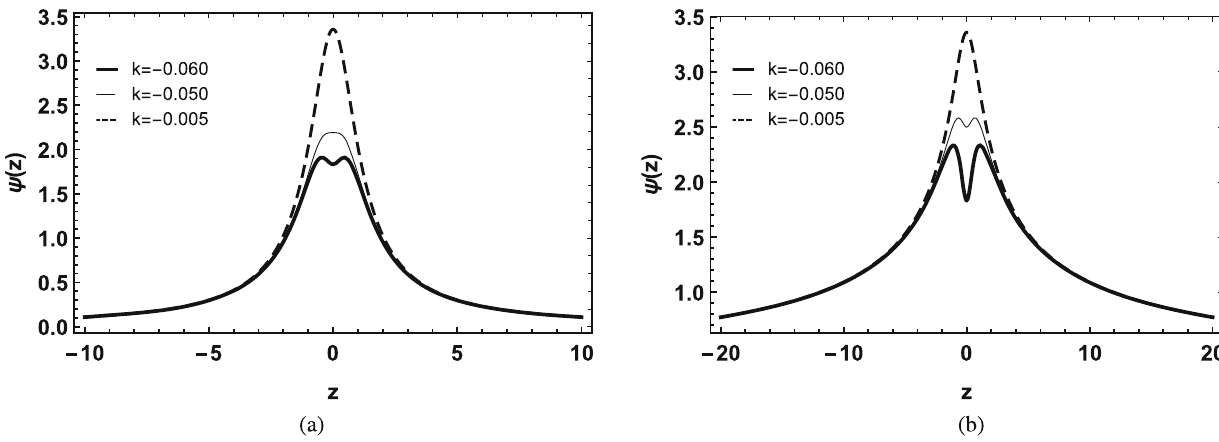
Fig. 13 Behavior of massless modes for G 1 ( T ) with n = 2 and p = λ = 1. a Gauge field. b KR field